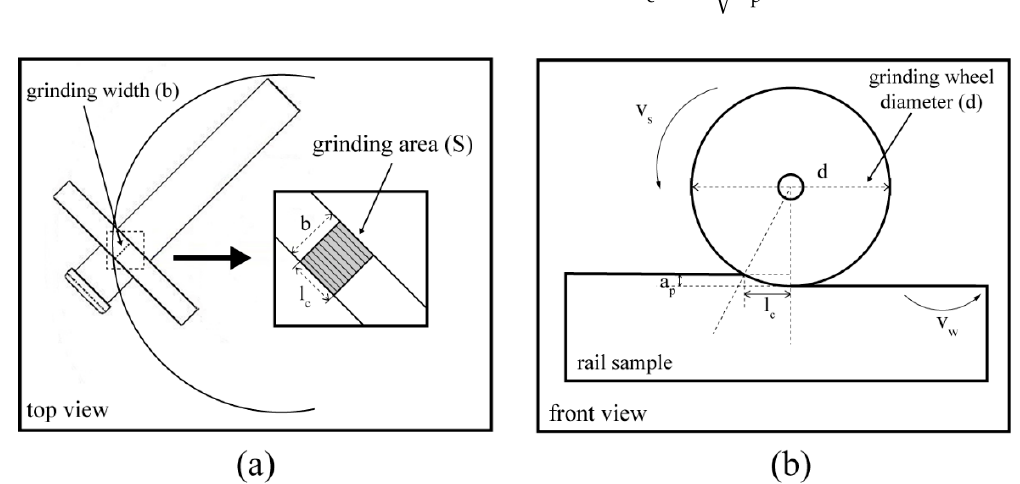
Figure 12. Grinding contact process between the grinding wheel and the workpiece, ( a ) top view, ( b ) front